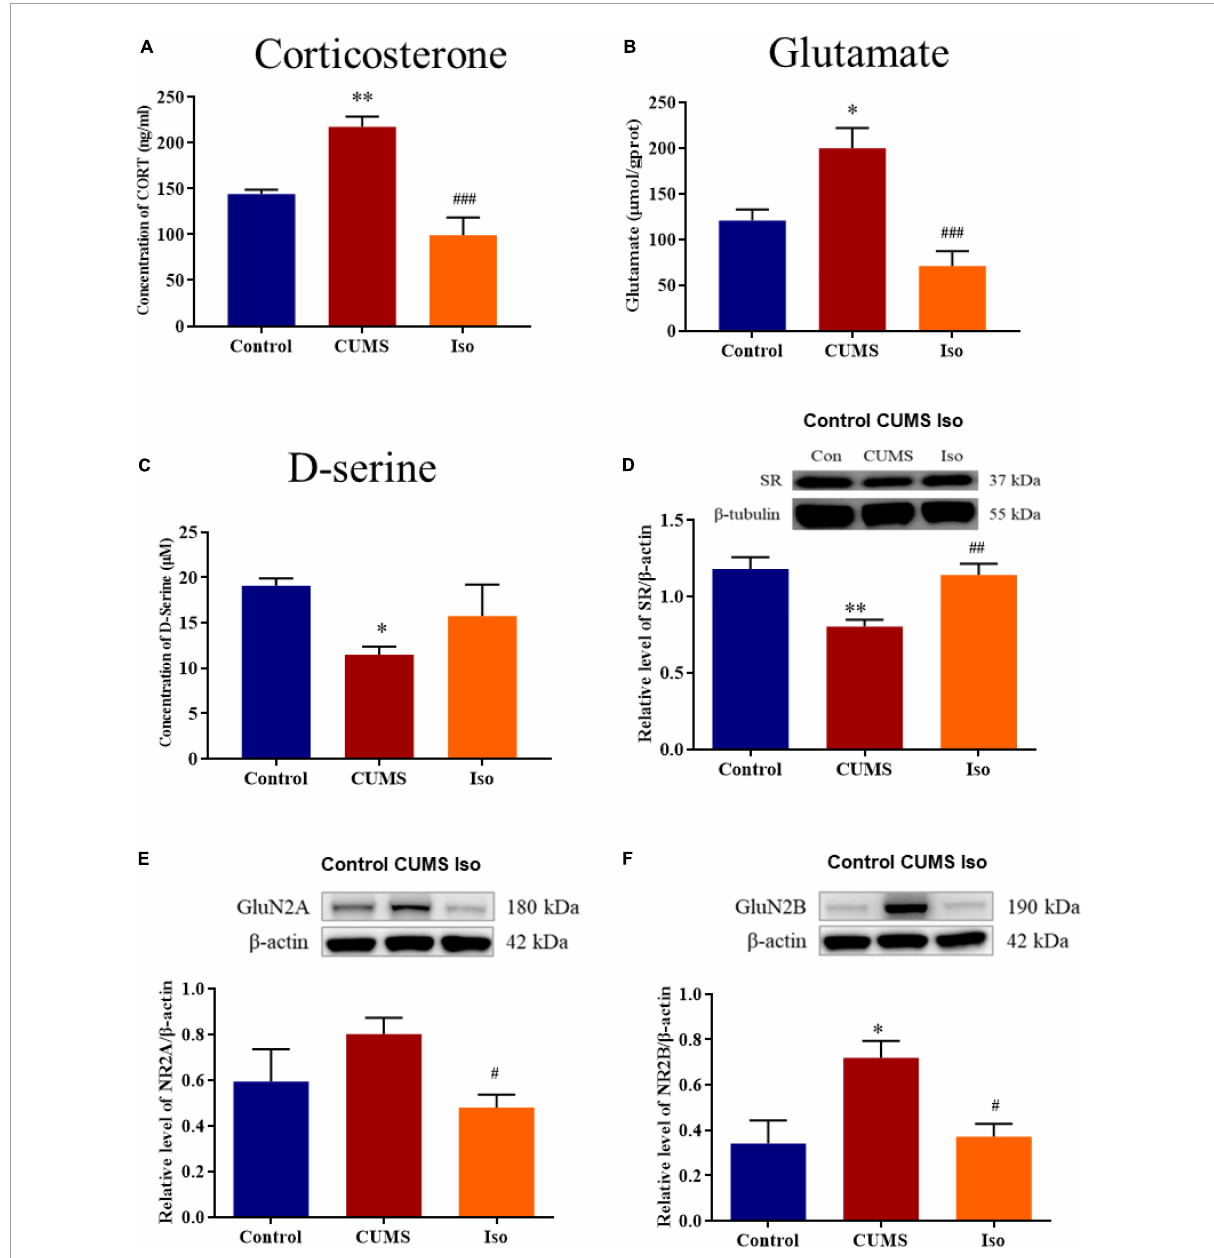
FIGURE4 Effects of isorhynchophylline on plasma corticosterone, glutamate, SR, D-serine, GluN2A and GluN2B in CUMS mice. (A) Isorhynchophylline significantly decreased the serum corticosterone level in CUMS mice. (B) Isorhynchophylline significantly decreased the hippocampal glutamate level in CUMS mice. (C) Isorhynchophylline increased the level of D-serine in CUMS mice. (D) Isorhynchophylline significantly increased the expression of SR in CUMS mice. (E) Isorhynchophylline significantly decreased the expression of GluN2A in CUMS mice. (F) Isorhynchophylline significantly decreased the expression of GluN2B in CUMS mice. The data are presented as mean ± SEM. ∗ P < 0.05, ∗∗ P < 0.01 compared to the Con group; # P < 0.05, ## P < 0.01, ## P < 0.001 compared to the CUMS